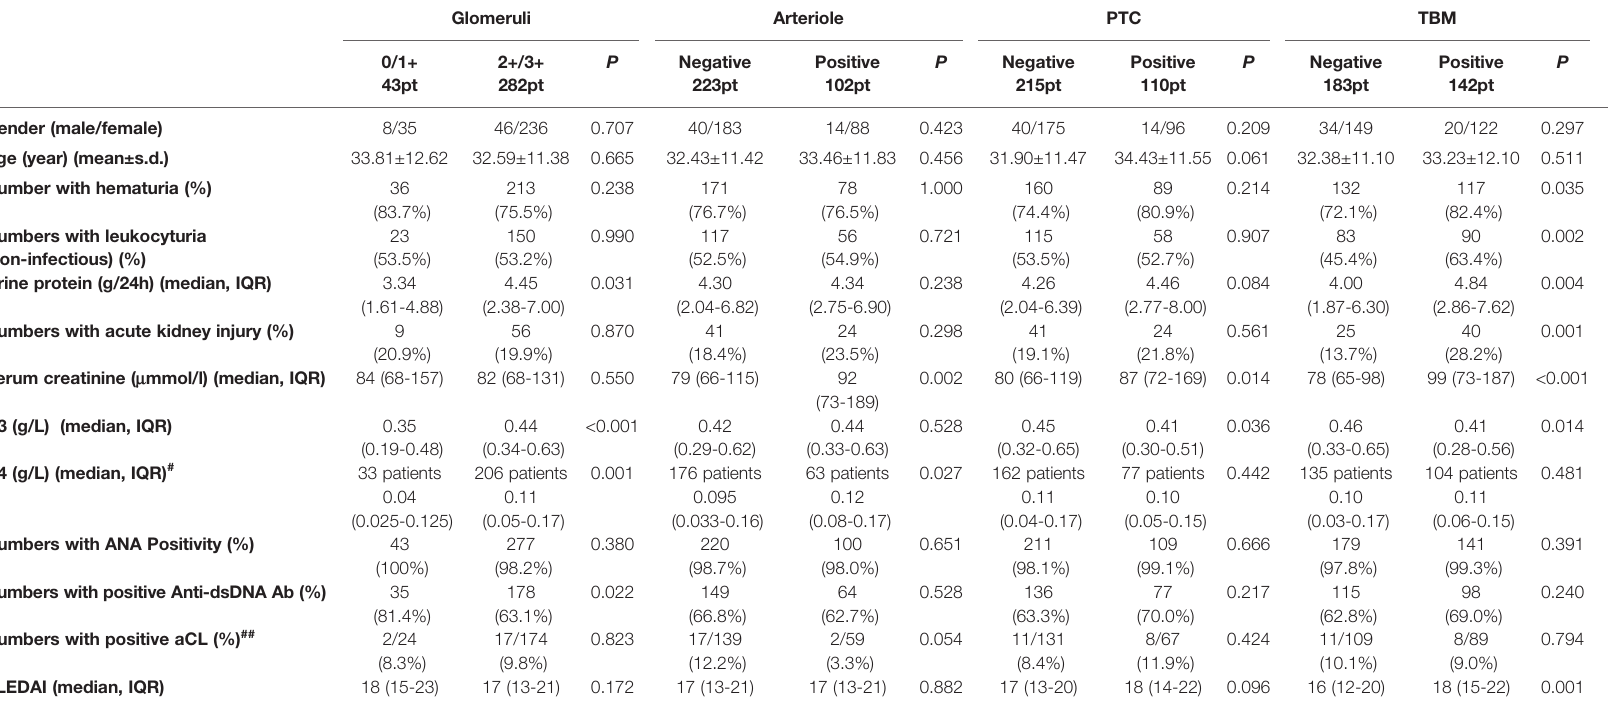
TABLE 3 | Comparison of clinical and laboratory data in patients with and without C4d deposition in different renal